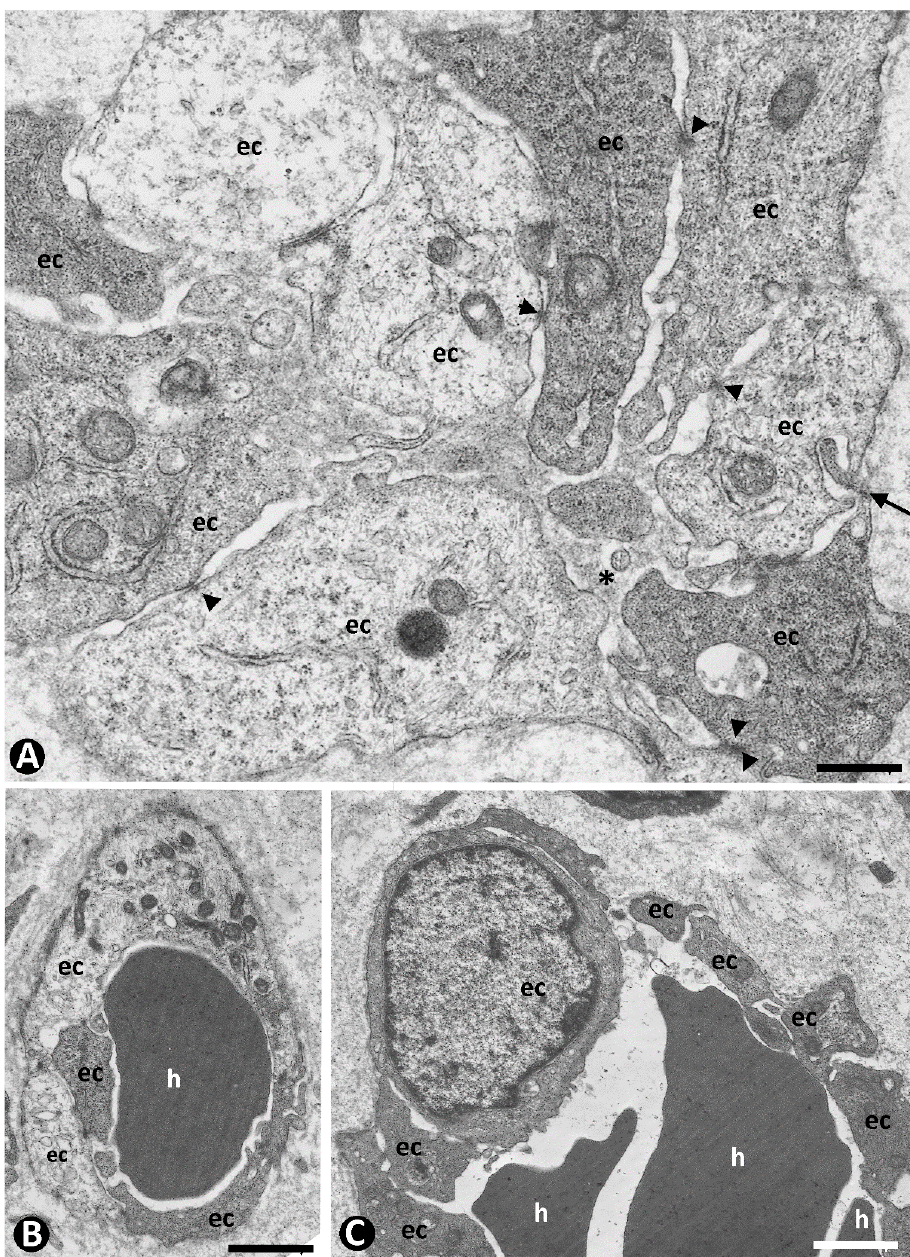
Figure 9. Ultrastructural characteristics of type 2 neovessels. ECs with discontinuities, different electron densities, small interendothelial junctions (arrowheads), and a peg-and-socket junction (( A ), arrow) form neovessels with virtual lumen (( A ), asterisk) and one ( B ) or several. ( C ) Red blood cells (h). Ultrathin sections. Uranyl acetate and lead citrate. Bar: ( A ): 0.7 µm; ( B ): 1.5 µm; ( C ): 1 µm